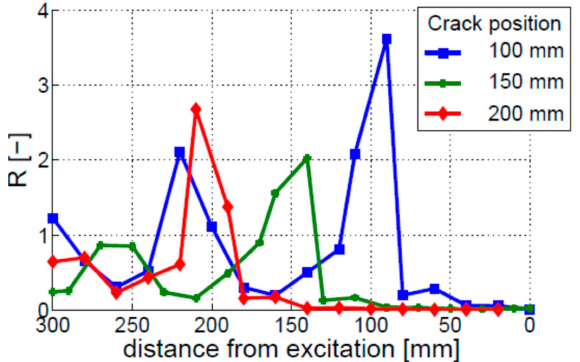
Figure 14. Crack localization effect for the breathing crack model. Three different single-crack locations are investigated, i.e., the cracks positioned 100, 150, and 200 mm away from the free end of the